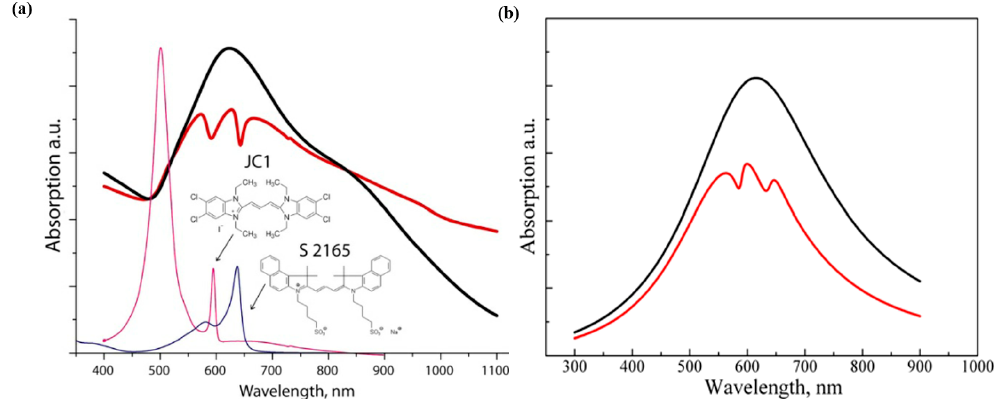
Figure 8. ( a ) Absorption spectra of gold nanostars (balck curve), pristine J-aggregates of JC1 (magenta curve) and S2165 (blue curve), and the hybrid structure (red curve). ( b ) Theoretical extinction spectra of gold nanostars (black curve) and their hybrid structure with J-aggregates (red curve). Adapted with permission from Ref. [126]. Copyright 2013 IEEE.